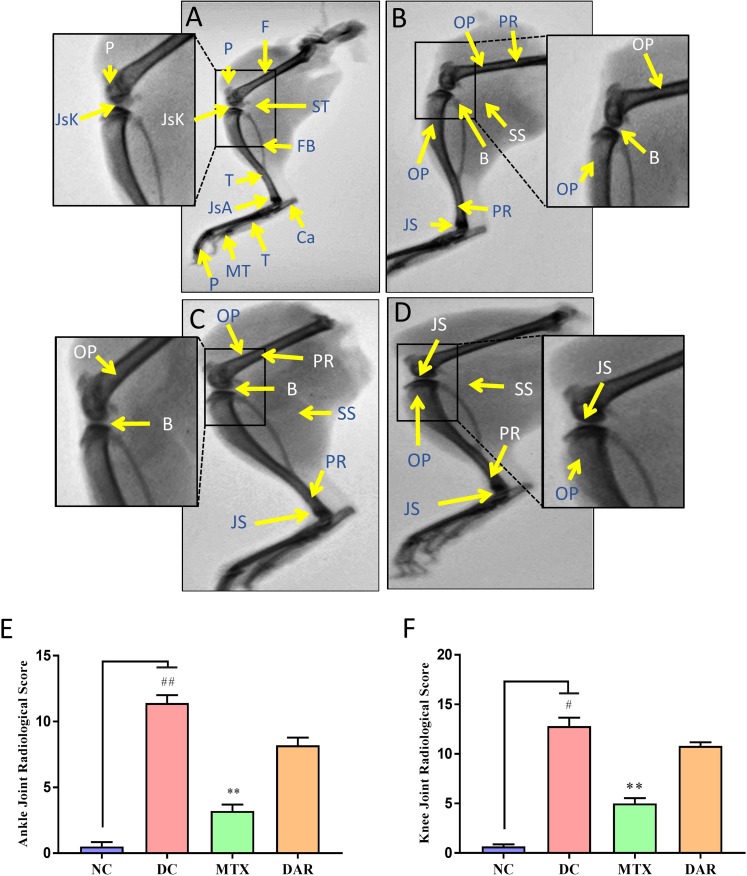
Radiological analysis of RA mice limbs: X-ray images of the hind legs were taken. (A) NC animal showing normal morphology of bones, viz., tibia (T), fibula (Fb), calcaneum (Ca), patella (P), femur (F), tarsals (T), metatarsals (MT), and phalanges (P). Normal joint space with healthy cartilage at the knee joint (JsK) and ankle joint (JsA) and periarticular soft tissue (ST); inset showing knee joint. (B) DC animal showing periosteal reaction/hypertrophy (PR), bone erosion (B), soft tissue swelling (SS), narrowed joint space (JS), and osteoporosis (OP); inset showing knee joint. (C) Methotrexate (MTX) treated CAIA animal showing PR, B, SS, JS, and OP; inset showing knee joint. (D) CAIA animal treated with DAR showing PR, SS, JS, and OP; inset showing knee joint. (E) Ankle-joint radiological score showed significant arthritis-induced bone damages in the DC animals. Treatment of the CAIA animals with DAR and MTX considerably reduced arthritis-induced bone damages. (F) Knee-joint radiological score showed results similar to those observed in the ankle joint of the CAIA animals. Non-parametric Kruskal–Wallis analysis was used to calculate the statistical difference in NC versus DC (p-value # < 0.05; ## < 0.01), MTX or DAR treatment versus DC (p-value * < 0.05; ** < 0.01).